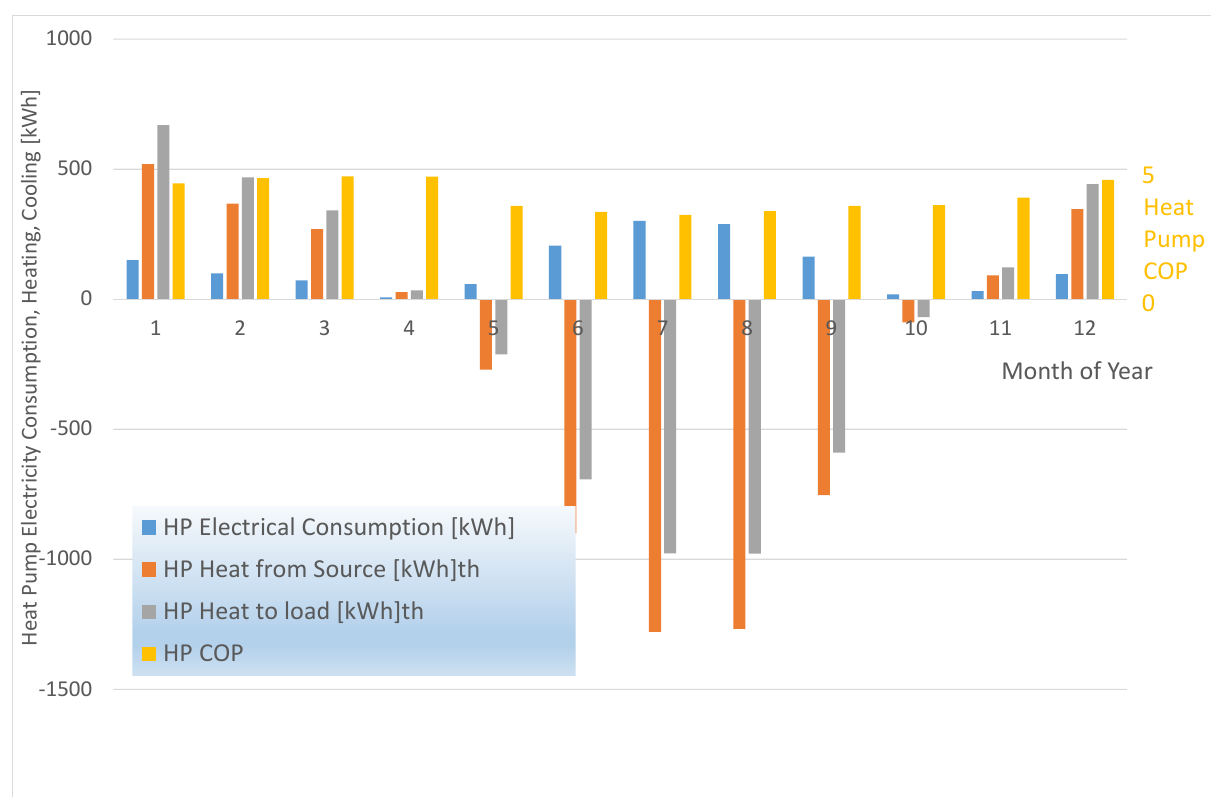
Figure 6. Monthly summaries of heat pump electricity consumption, heat from source and heat to load. Cooling mode prevails during months May to October, as seen by the negative (cooling) kWh.